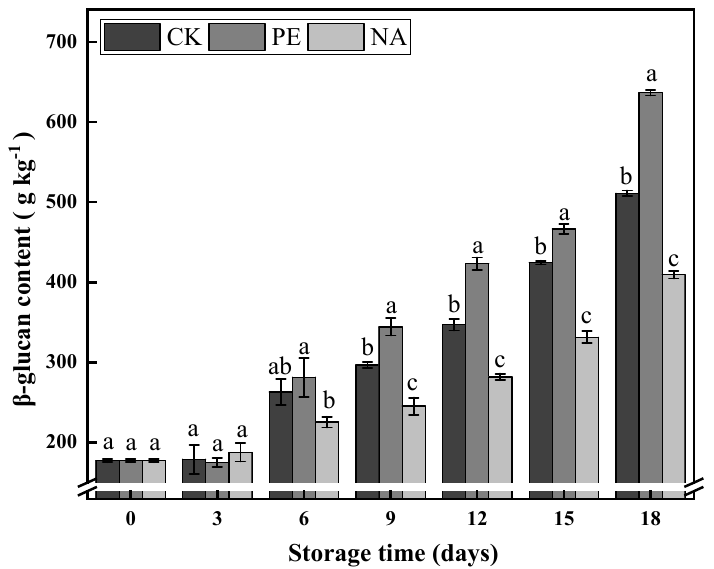
F. velutipes Figure 6. Effects of different types of packaging on the content of β -glucan in the elongation area of F. velutipes stipes.